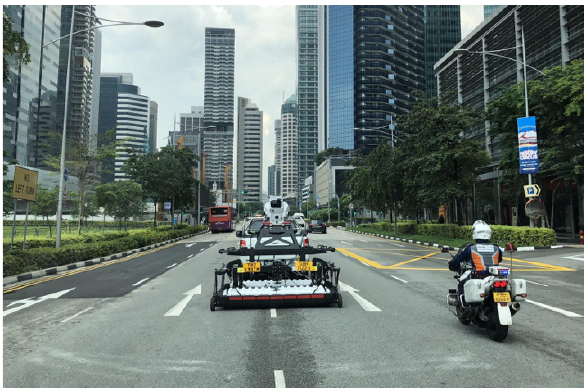
Figure 7. Scanning in between two lanes on a five-lane road, Marina Boulevard.